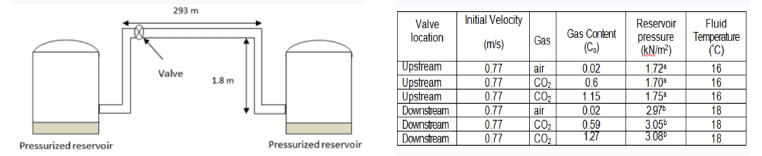
Figure 5. Pipe system and data of